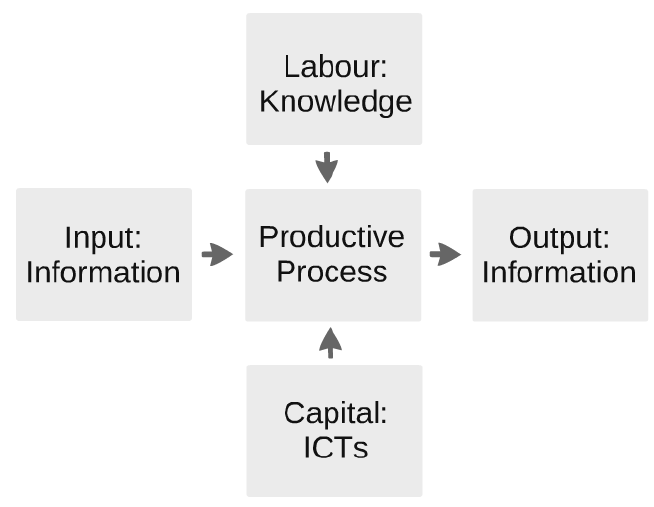
Figure 2: A basic structure of the digital production